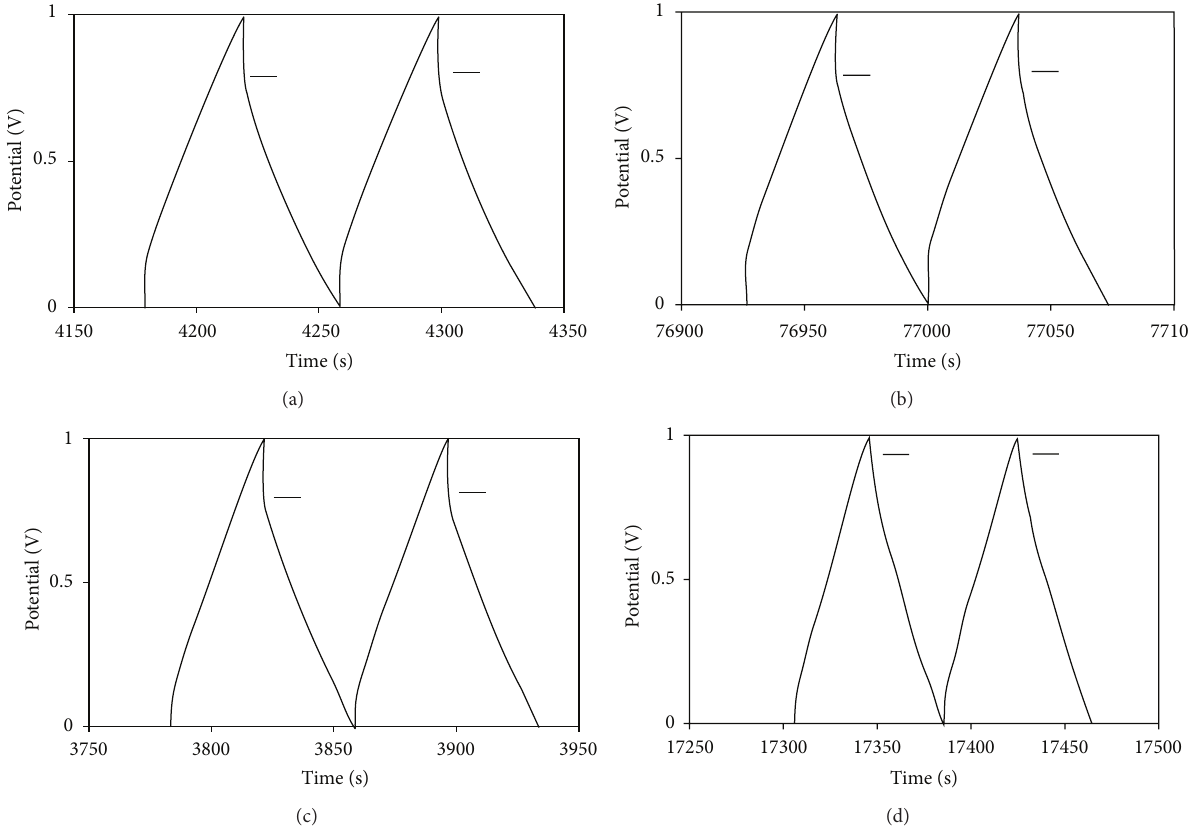
Figure 9: Constant current charge discharge characteristics of GNPs-based electrodes at 1A/g discharge current density. ((a), (b)) charge- discharge characteristics of unreduced GNPs at 50th and 1000th cycles and ((c), (d)) charge-discharge characteristics of reduced GNPs at 50th and 1000th